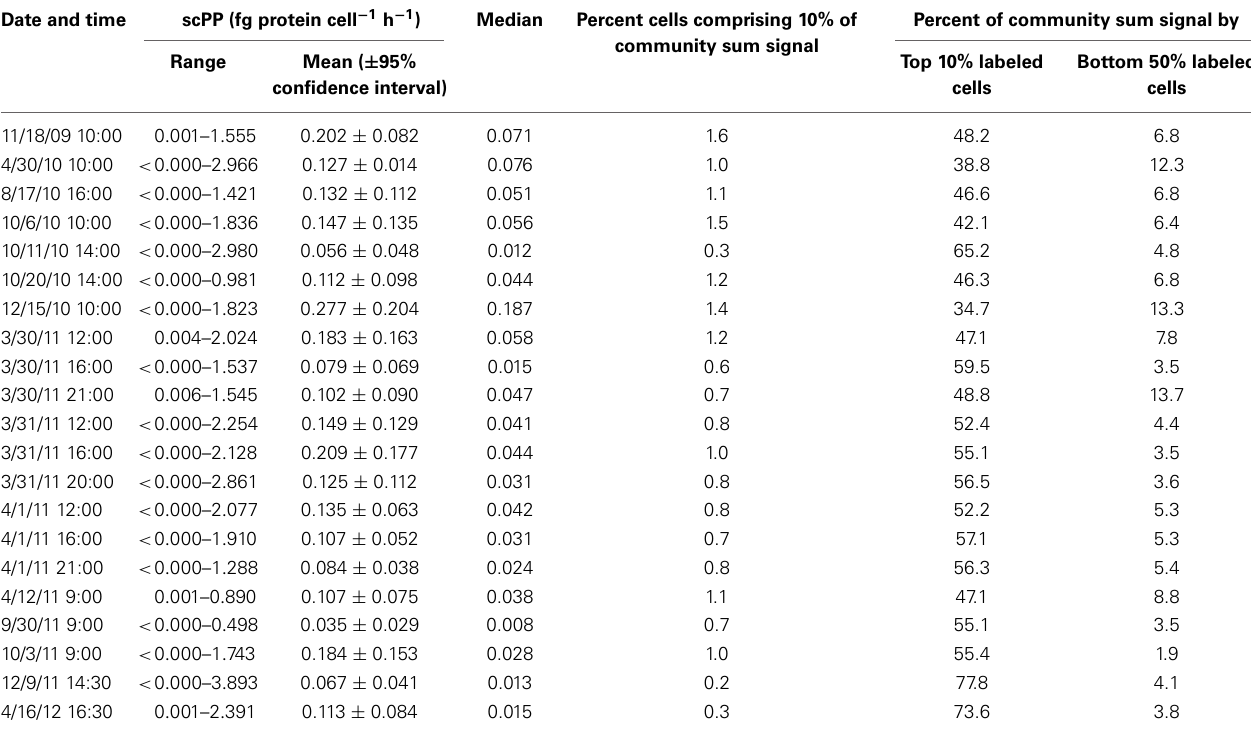
Table 3 | Overview of protein synthesis rates for 21 sampling dates at Scripps Pier incubated with 20nM HPG for 1h.